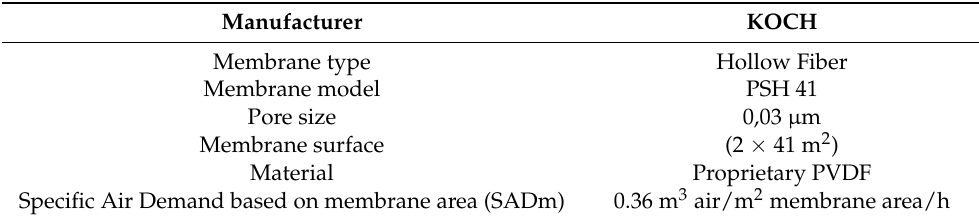
Table 1. Membrane characteristics.